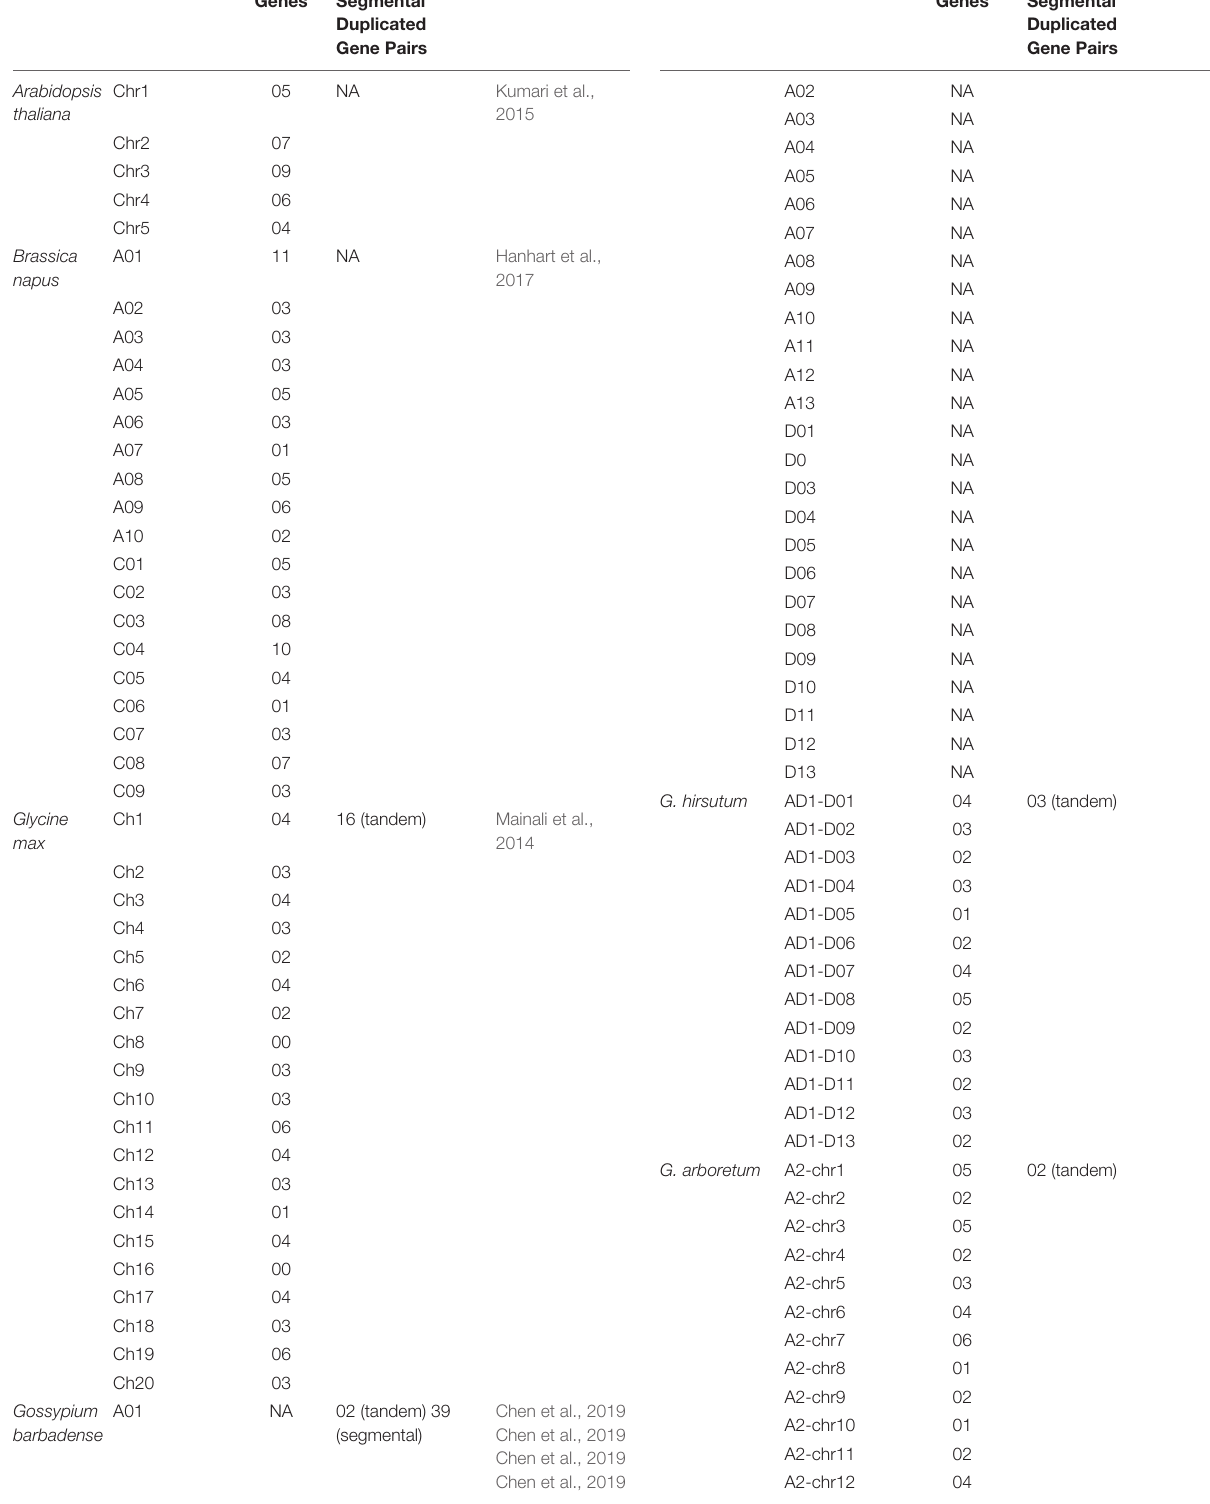
TABLE 3 | Chromosomal distribution of cyclophilin genes in plants. Organism Chromosome Cyclophilin